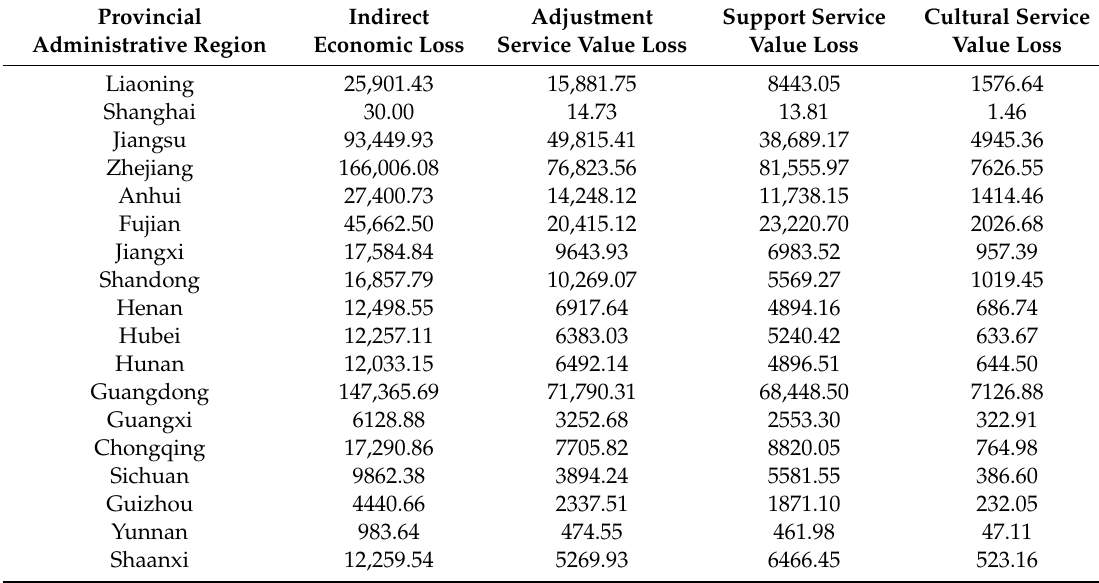
Table A10. Indirect economic losses on the provincial level in Mainland China from 1998 to 2017 (Secondary indicators) / 10 4